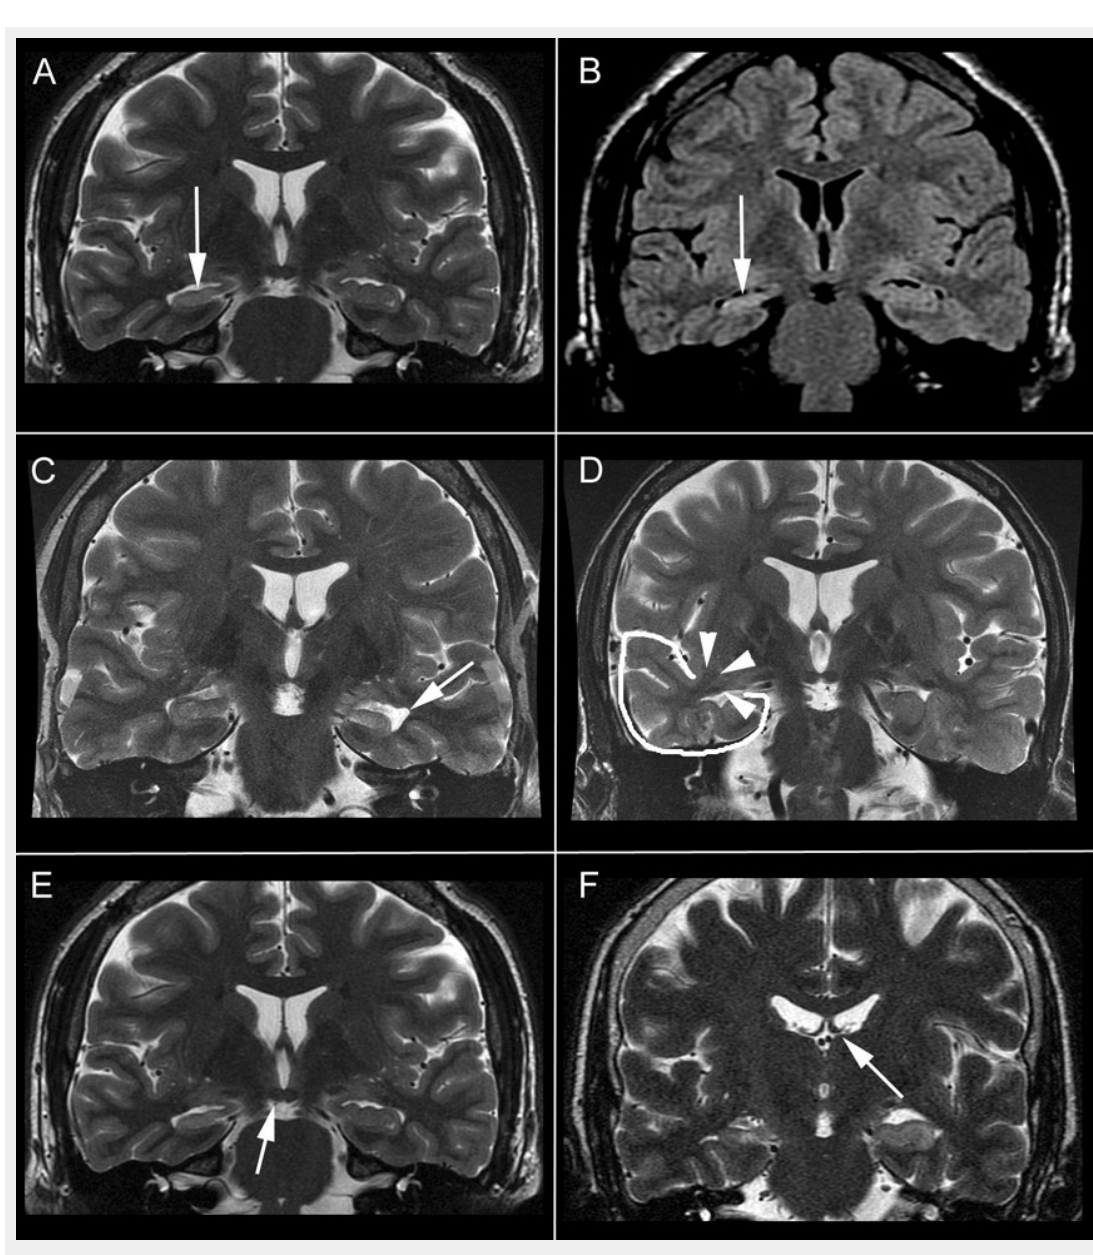
Figure 1 Primary- and secondary findings in mesial temporal sclerosis. A and B, Coronal T2 and Flair brain MR images showing atrophy and hyperintensity in the right hippocampus (white arrows). C, choroidal fissure dilatation. D, temporal lobe atrophy (white contour) and collateral white matter atrophy (white arrow heads). E, mamillary body asymmetry. F, fornix